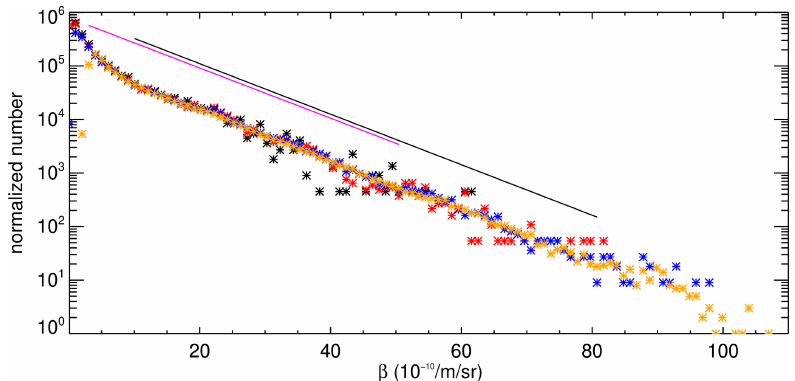
Figure 5. Histogram of volume backscatter coefficients β between 79 and 86km altitude at 300m × 5min (black), 180m × 1min (red), 60m × 30s (blue), and 20m × 10s (orange) resolution and scaled to account for the different number of bins. The slope α BOLIDE = − 0 . 1086 ± 0 . 0005 of the black line was fitted to the data in the range β = 10 to 80 × 10 − 10 m − 1 sr − 1 . The magenta line with α − 0 . 1079 ± 0 . 0045 was determined from the ALOMAR RMR lidar dataset by Berger et al. (2019).